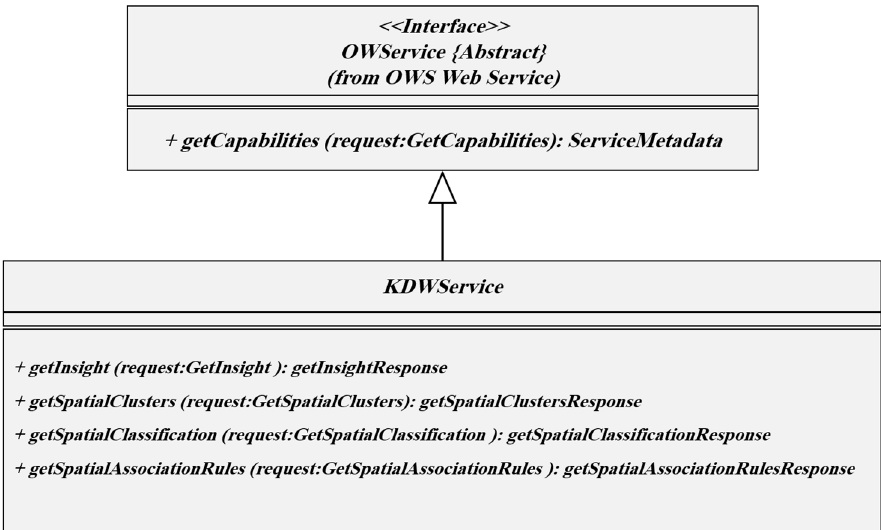
Figure 3. Class diagram of the Knowledge Discovery Web Service (KDWS).